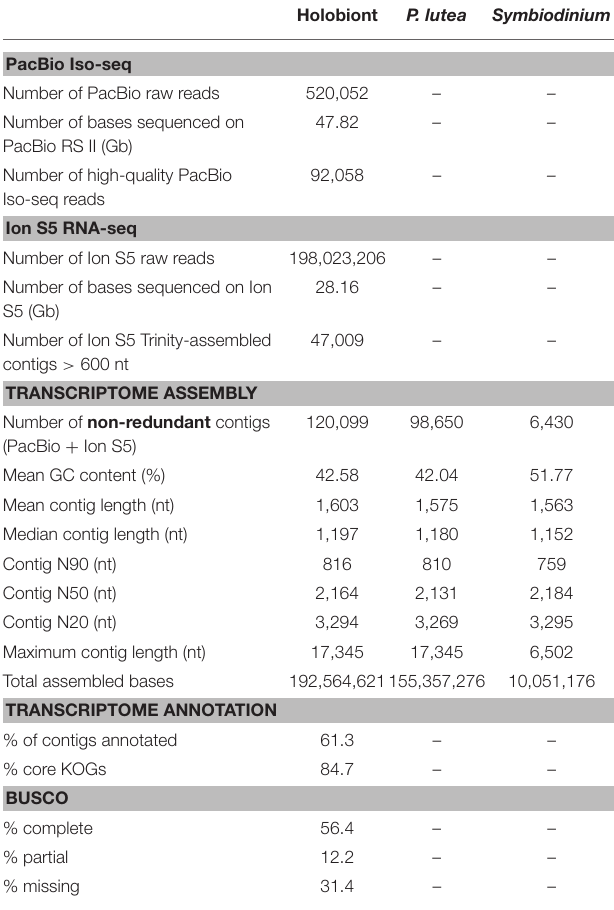
TABLE 1 | Assembly statistics for the holobiont